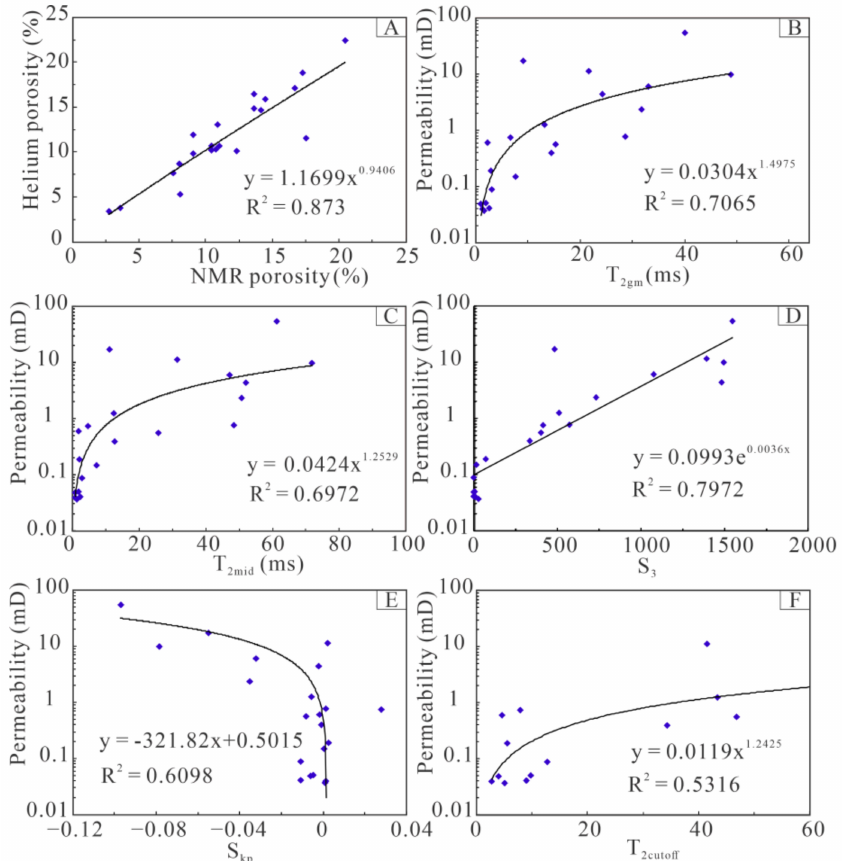
Figure 12. Relationships between NMR T 2 spectral parameters and petrophysical properties. ( A ) NMR porosity versus helium porosity; ( B ) T 2gm versus permeability; ( C ) T 2mid versus per- meability; ( D ) S 3 versus permeability; ( E ) S kp versus permeability; ( F ) T 2cutoff versus